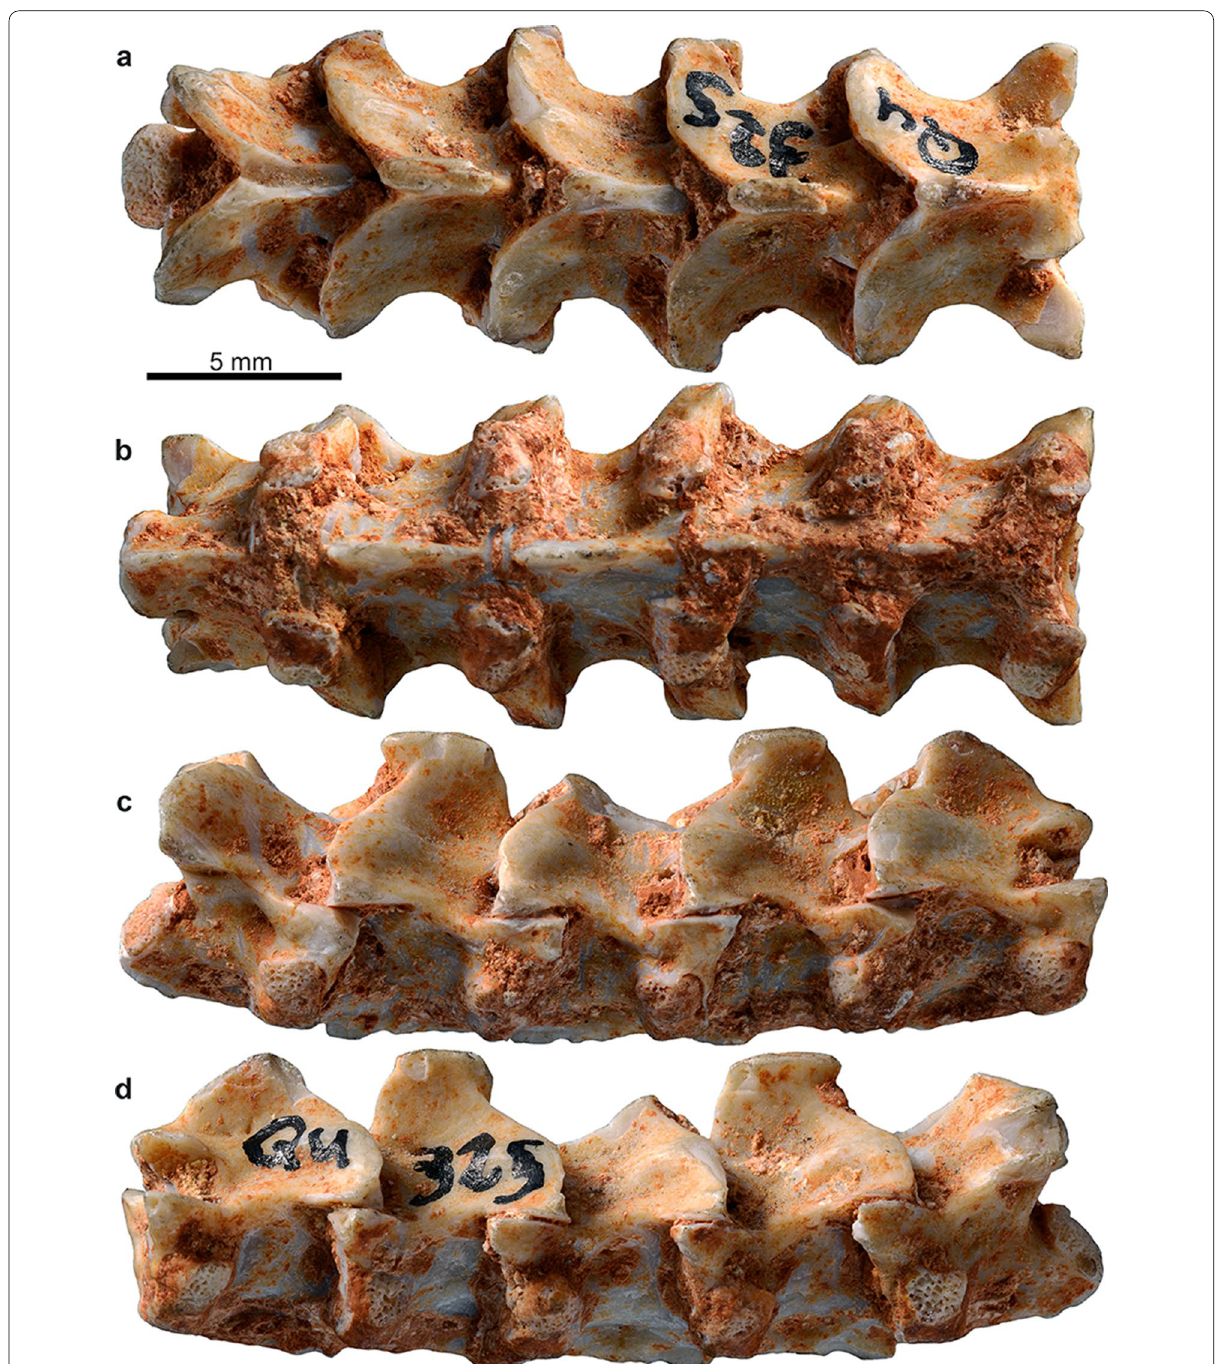
(MNHN.F QU16325) in dorsal ( a ), ventral ( b ), right lateral ( c ), and left lateral ( d )